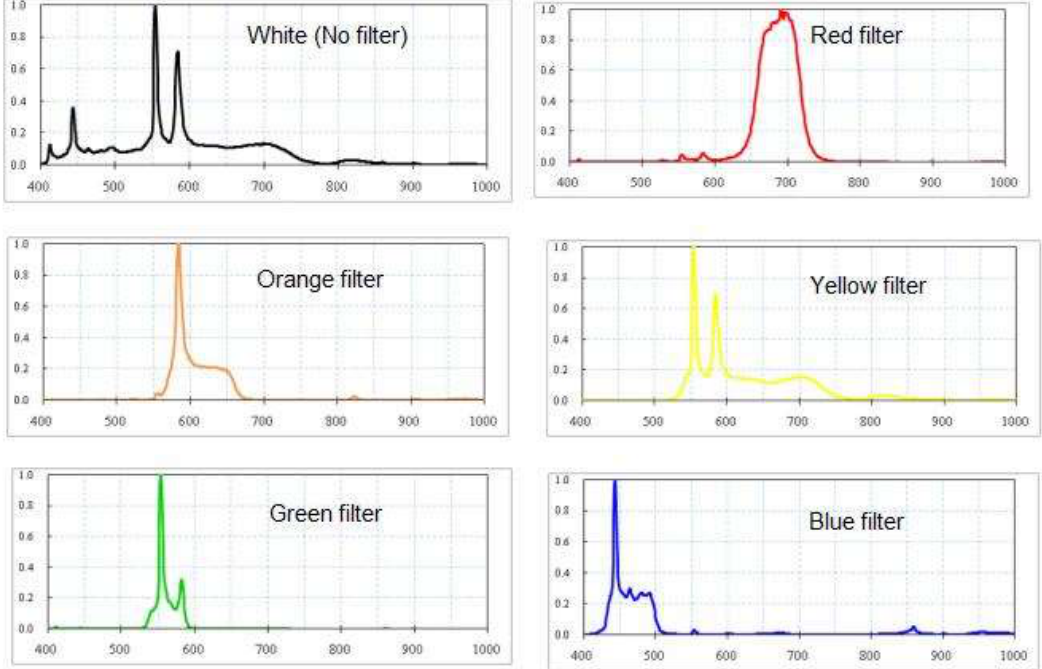
Figure 2. Spectrum distribution of metal-halide light source.